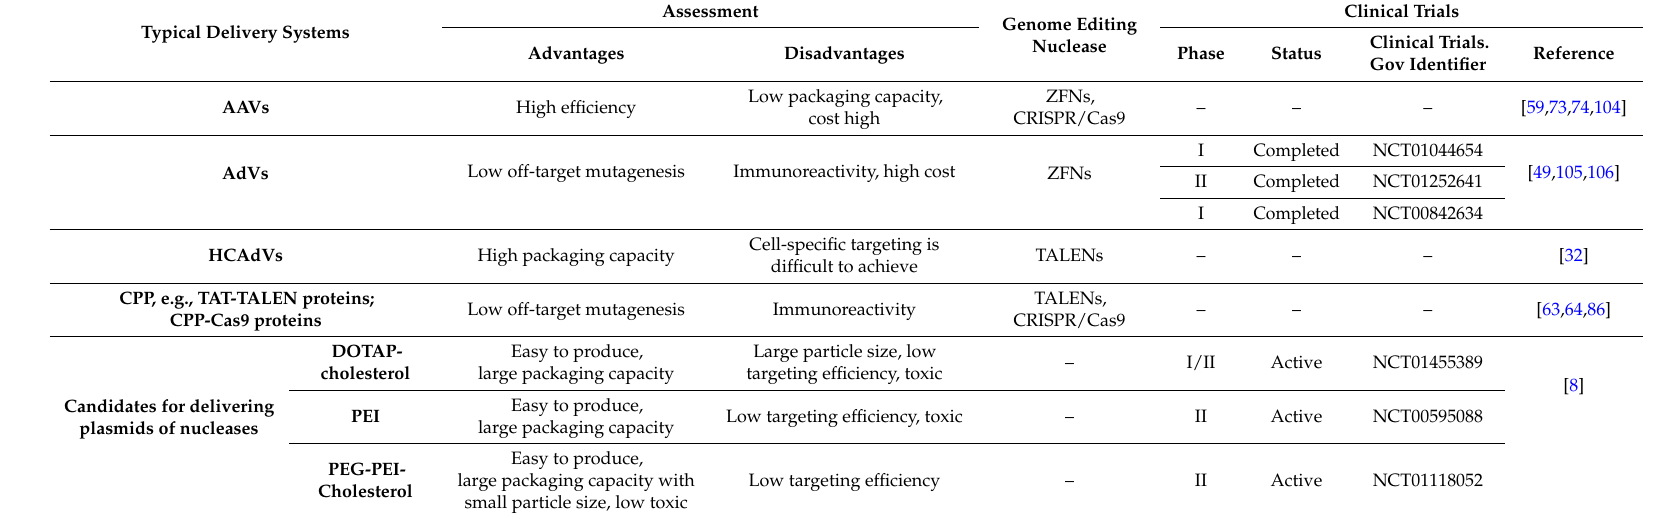
Table 1. Summary form of typical in vivo delivery systems and candidates for genome editing nucleases and their expression cassette.